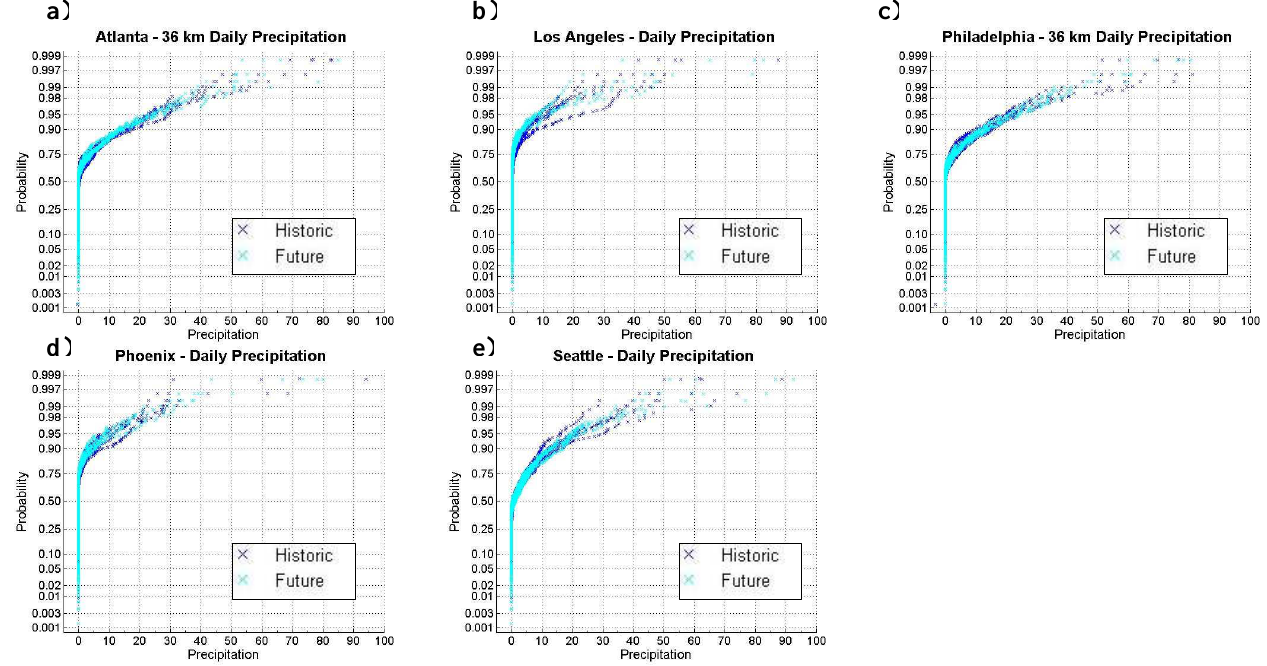
Fig. 10. Cumulative distribution of 36km historic (dark) and future (light) daily precipitation at major US cities: (a) Atlanta (b) Los Angeles (c) Philadelphia (d) Phoenix and (e)